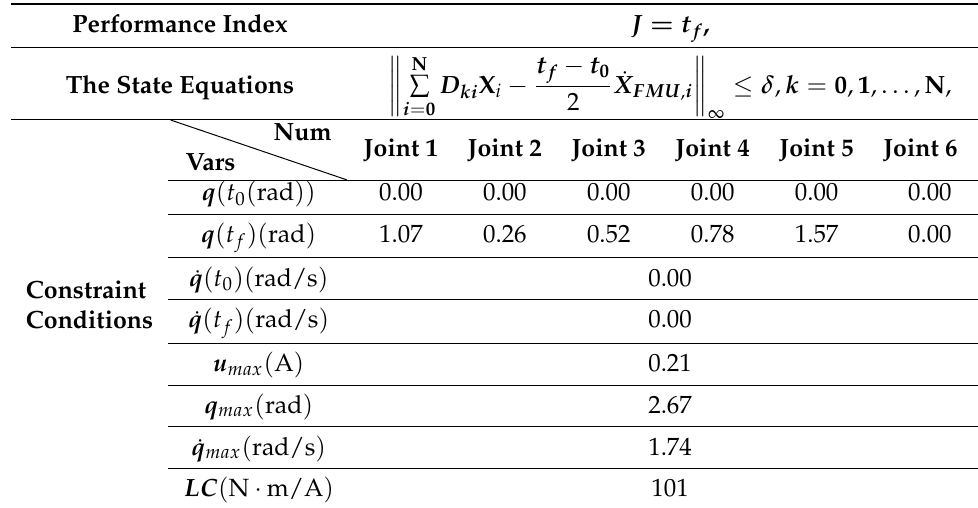
Table A4. The OCP